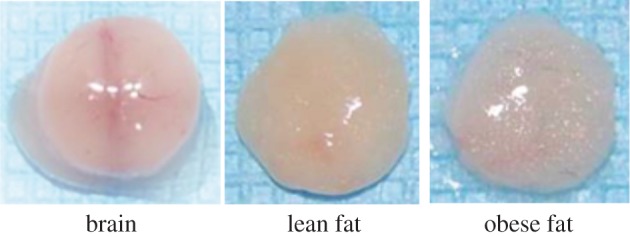
Typical samples of brain, obese, and lean fat tissues are cut using an 8 mm diameter stainless steel punch. Major brain structures, such as cerebellum and olfactory bulb, are removed. The samples did not exhibit any anisotropic characteristics.